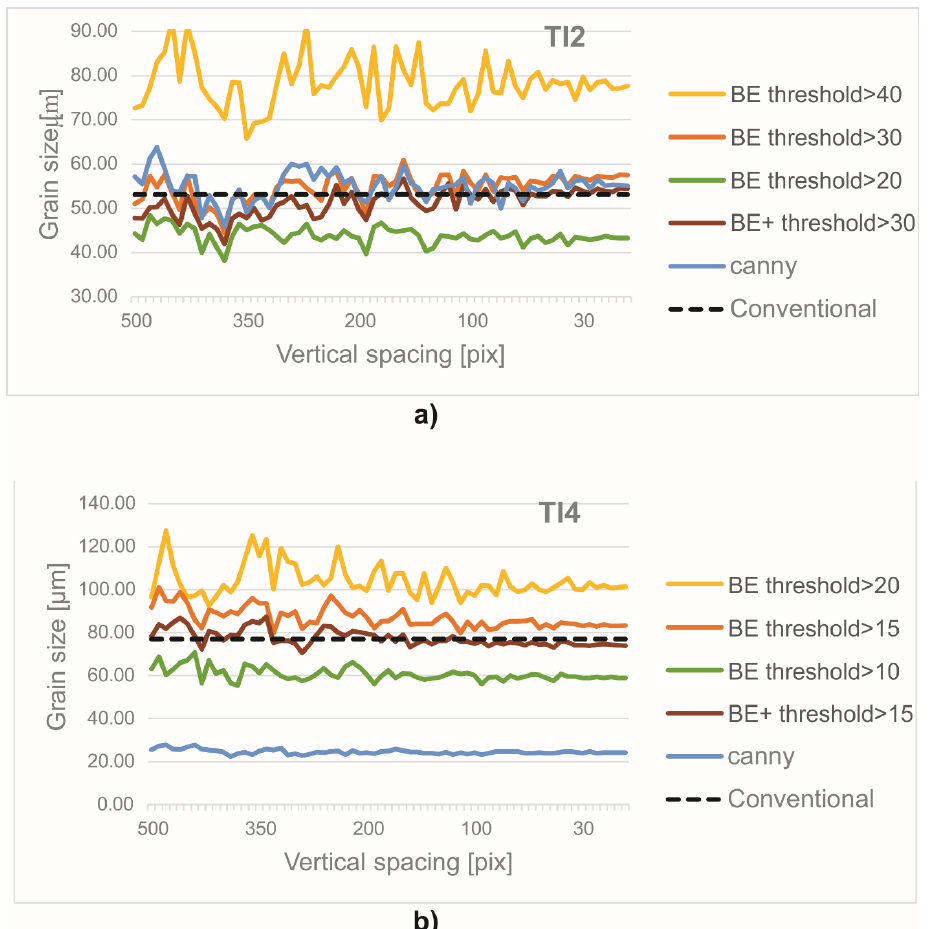
Figure 10. BE, BE+ and Canny edge detection grain size measurements with different spacing values for TI2 ( a ) and TI4 ( b ), compared to the conventional grain size determination